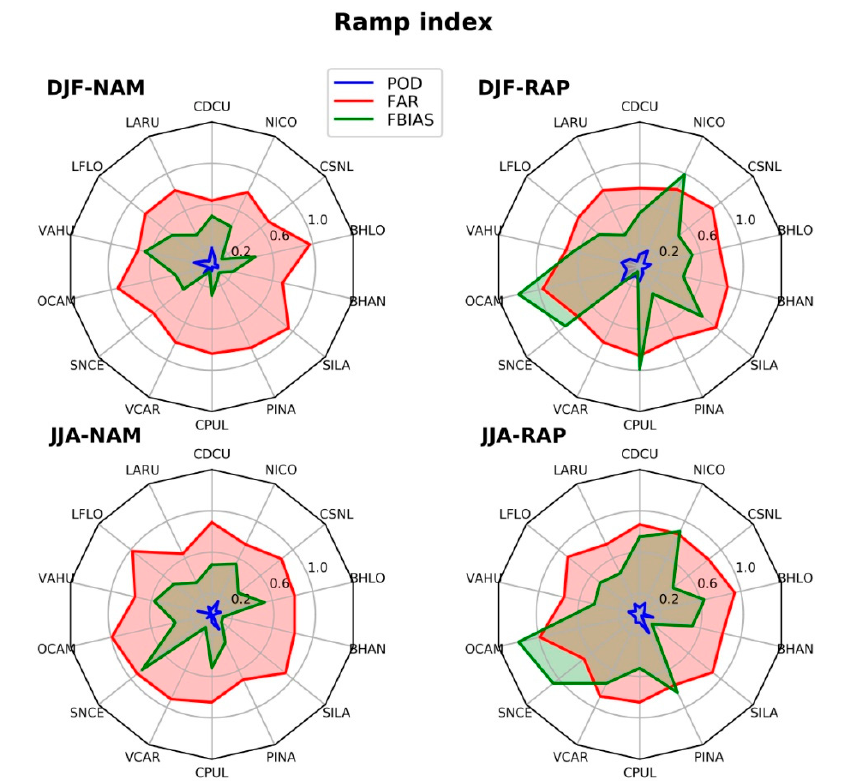
Figure 12. 2013 Seasonal Probability of detection (POD), False Alarm Rate (FAR) and Frequency Bias (FBIAS) metrics for forecast wind ramps by NAM and RAP models. Ramp event is defined as a variation of 20% in wind power in one hour.